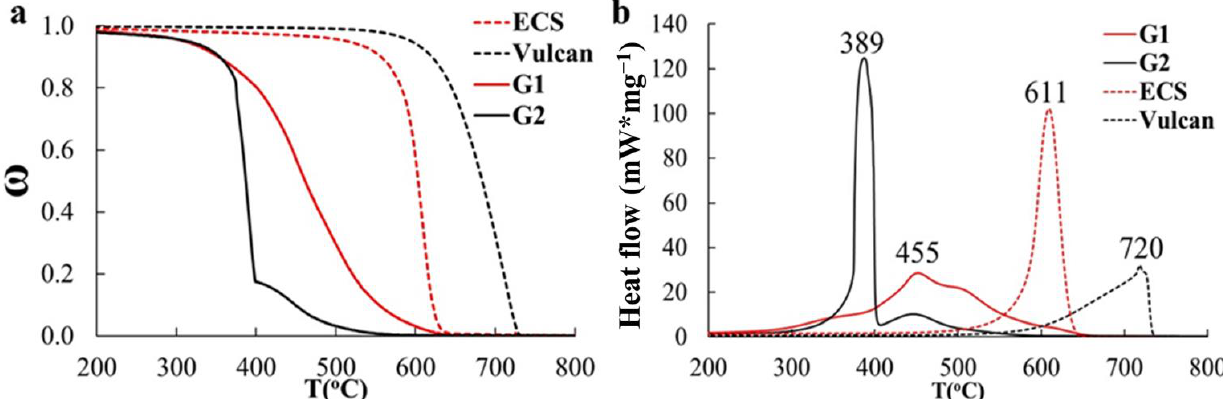
Figure 5. ( a ) TGA and ( b ) DSC curves of Pt/C catalysts and Vulcan and ECS